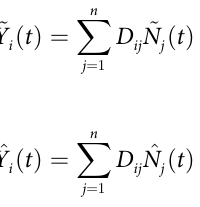
Table 1. The parameters for the population dynamics model and the disease model. Name Symbol Value Carrying capacity of ACP in a cell K 150000 (Based on 300 ACP per tree and 500 trees ha -1 ) Number of surviving offspring at low density σ 12 Probability infection is passed from tree to ACP β 0.0033 � Probability infection is passed from ACP to tree α 0.0033